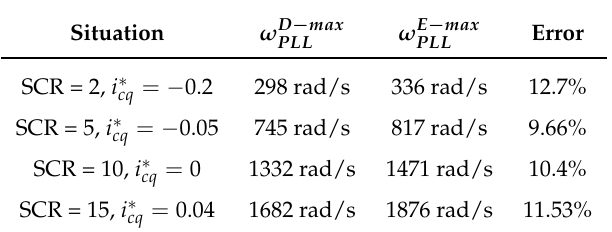
Table 3. Errors of the eigenvalue-based impedance stability analysis in terms of various